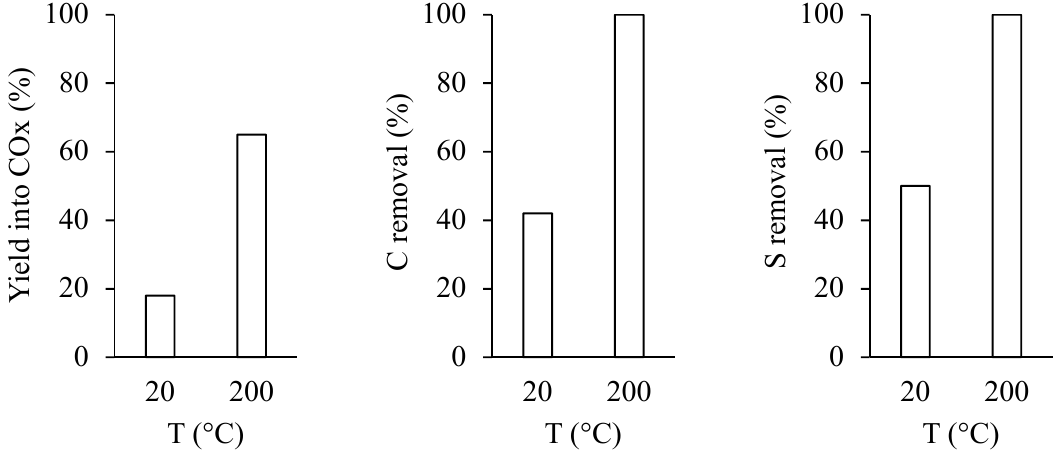
Figure 7. Influence of temperature on the yield into CO x , C, and S removal after 60 min of plasma treatment at 7 W.